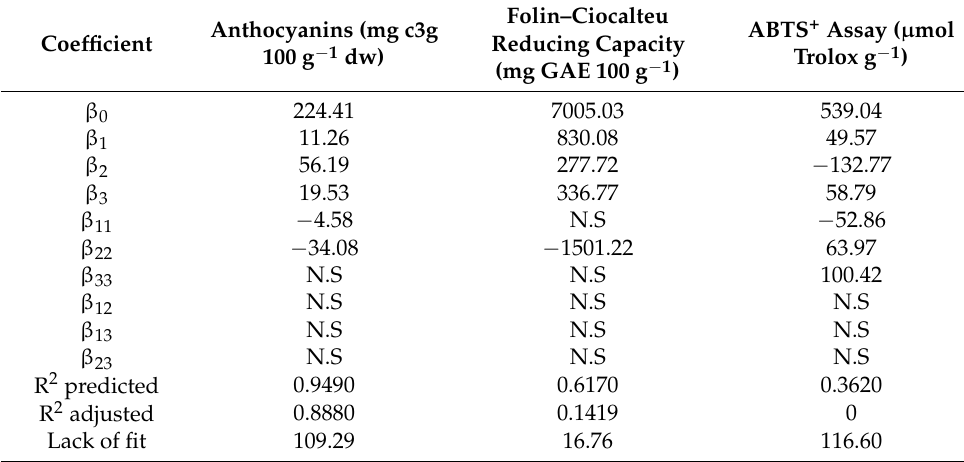
Table 2. Coefficient second-order regression for total anthocyanins monomeric content, Folin– Ciocalteu reducing capacity and ABTS+